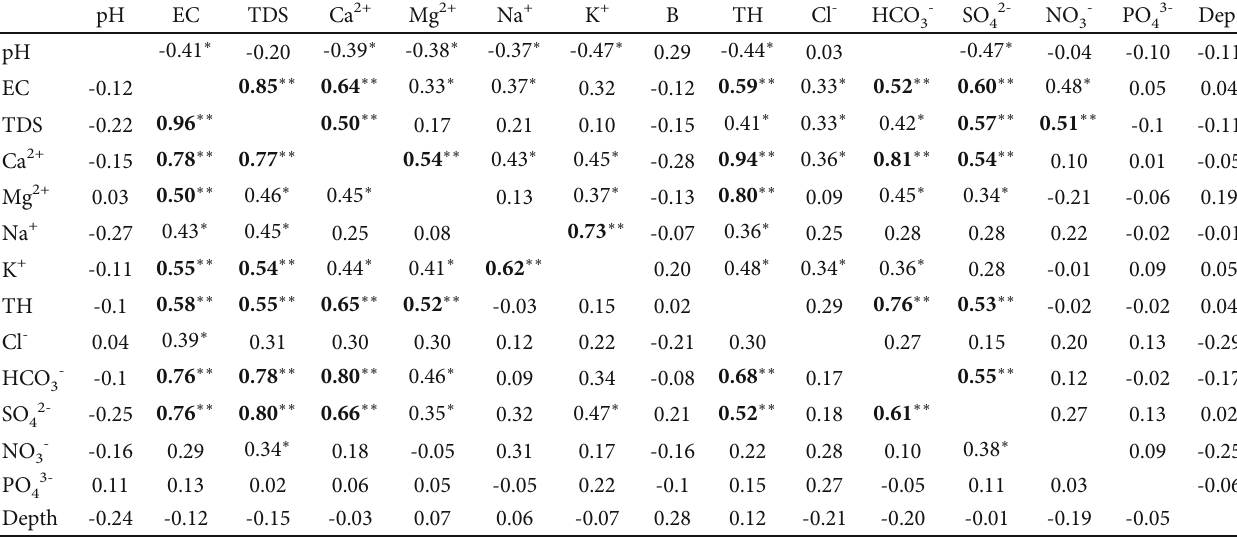
Table 3: Pearson ’ s correlation matrix of analyzing groundwater quality parameters in PRM (left side) and POM (right